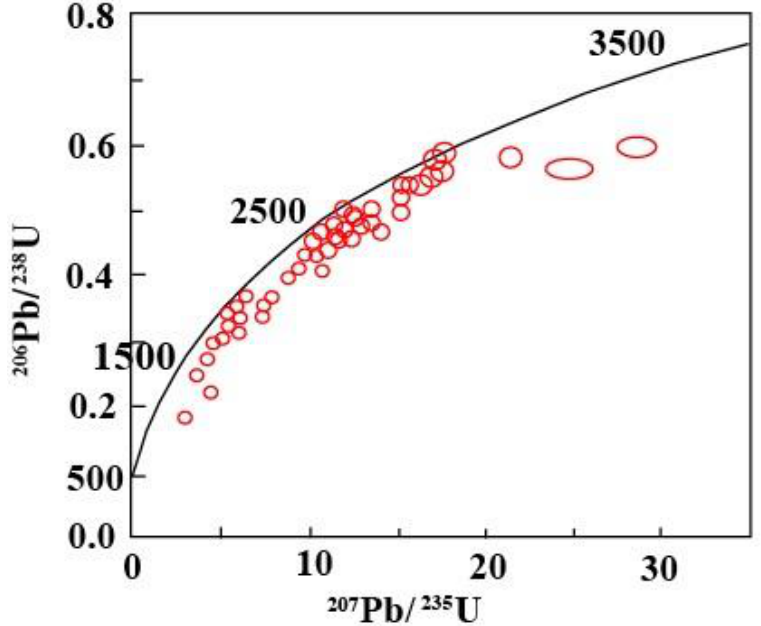
Figure 6. U-Pb discordia diagram for the southern Meiganga detrital zircons.